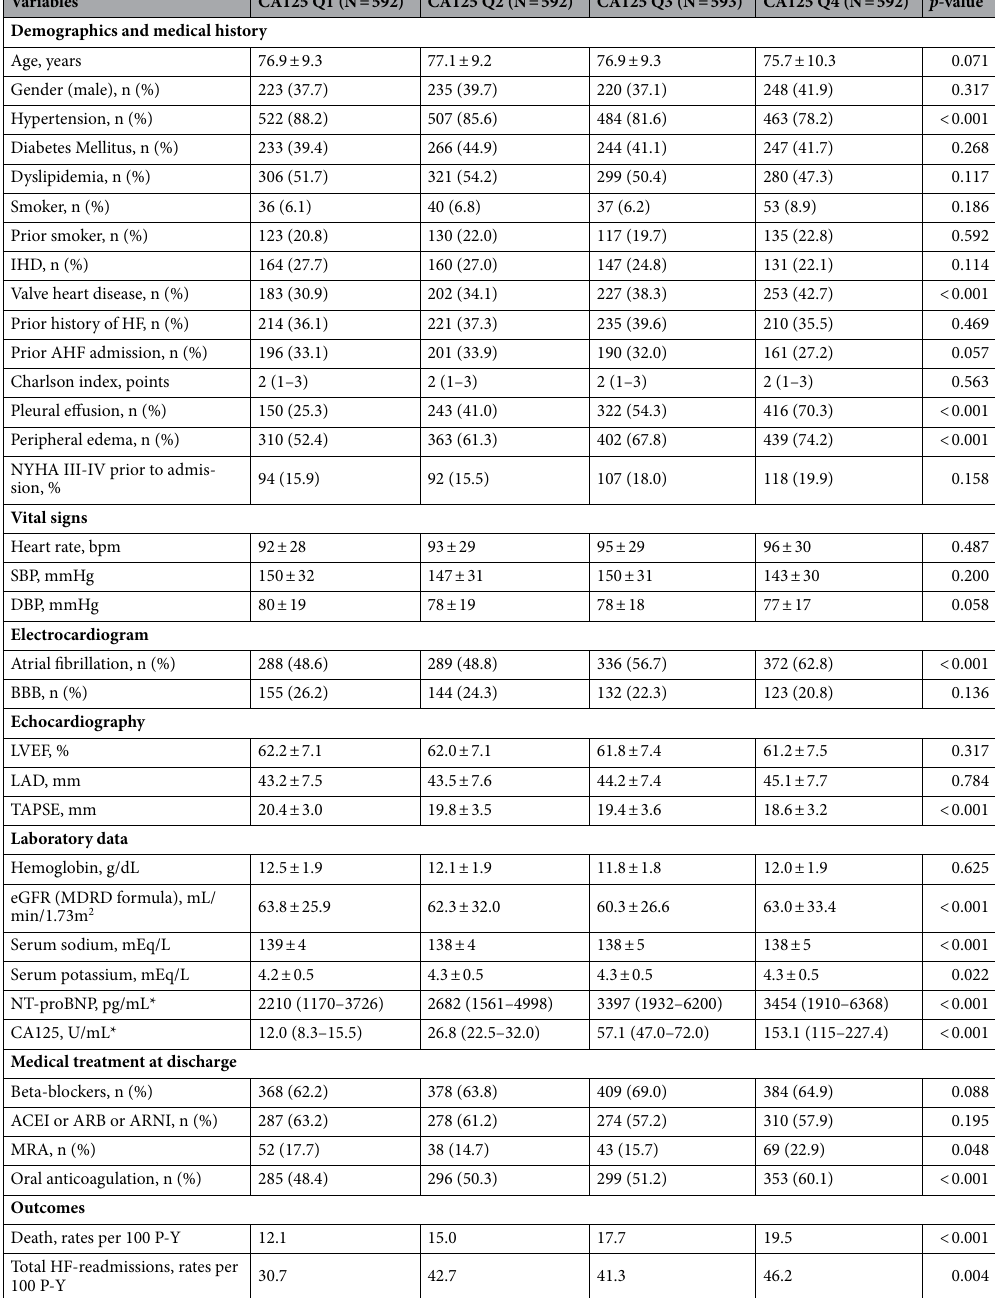
Table 1. Baseline characteristics across CA125 quartiles. AHF: acute heart failure; BBB: bundle branch block; CA125: carbohydrate antigen 125; DBP: diastolic blood pressure; eGFR: estimated glomerular filtration rate; ID: iron deficiency; IHD: ischemic heart disease; LAD: left atrial diameter; MDRD: Modification of Diet in Renal Disease; MRA: mineralocorticoid receptor antagonists; NT-proBNP: amino-terminal pro- brain natriuretic peptide; NYHA: New York Heart Association; PASP: pulmonary artery systolic pressure; P-Y: person-years; SBP:systolic blood pressure; TAPSE: tricuspid annular plane systolic excursion; TSAT: transferrin saturation; WHO: World Heart Organization. Values for continuous variables are expressed as mean ± standard deviation. *Values expressed as mean (interquartile range). CA125 quartiles: Q1 = 1.4–19 U/ mL; Q2 = 19–38.26 U/mL; Q3 = 38.3–90 U/mL; Q4 = 90–1500